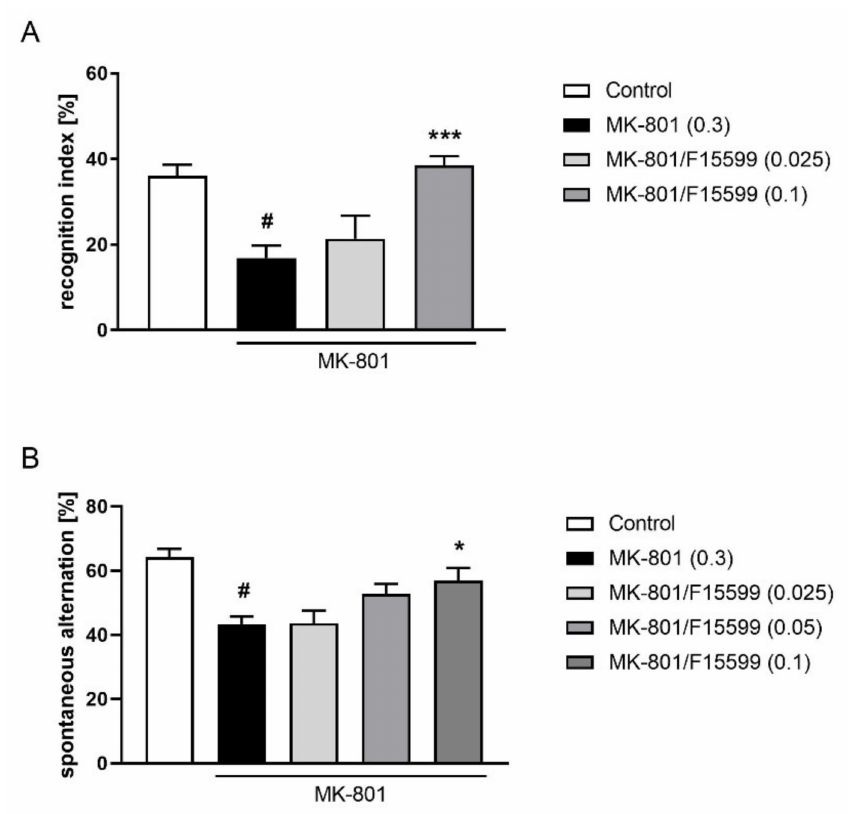
Figure 8. Activity of F15599 in the NOR ( A ) or Y-maze ( B ) test after seven days of treatment. The data are presented as means ± SEM. Doses of the compounds are indicated in parentheses. # p < 0.001 compared to control animals and * p < 0.05, *** p < 0.001 compared to MK-801-treated